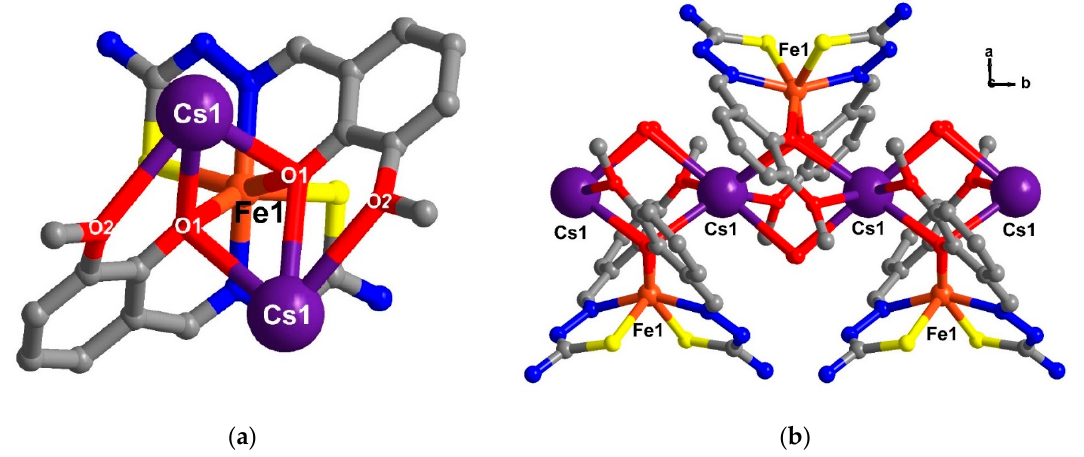
Figure 7. Representation of ( a ) the coordination bonds between Cs cations and adjacent Fe(III) molecules and ( b ) a 1D chain polymeric motif in 5 .